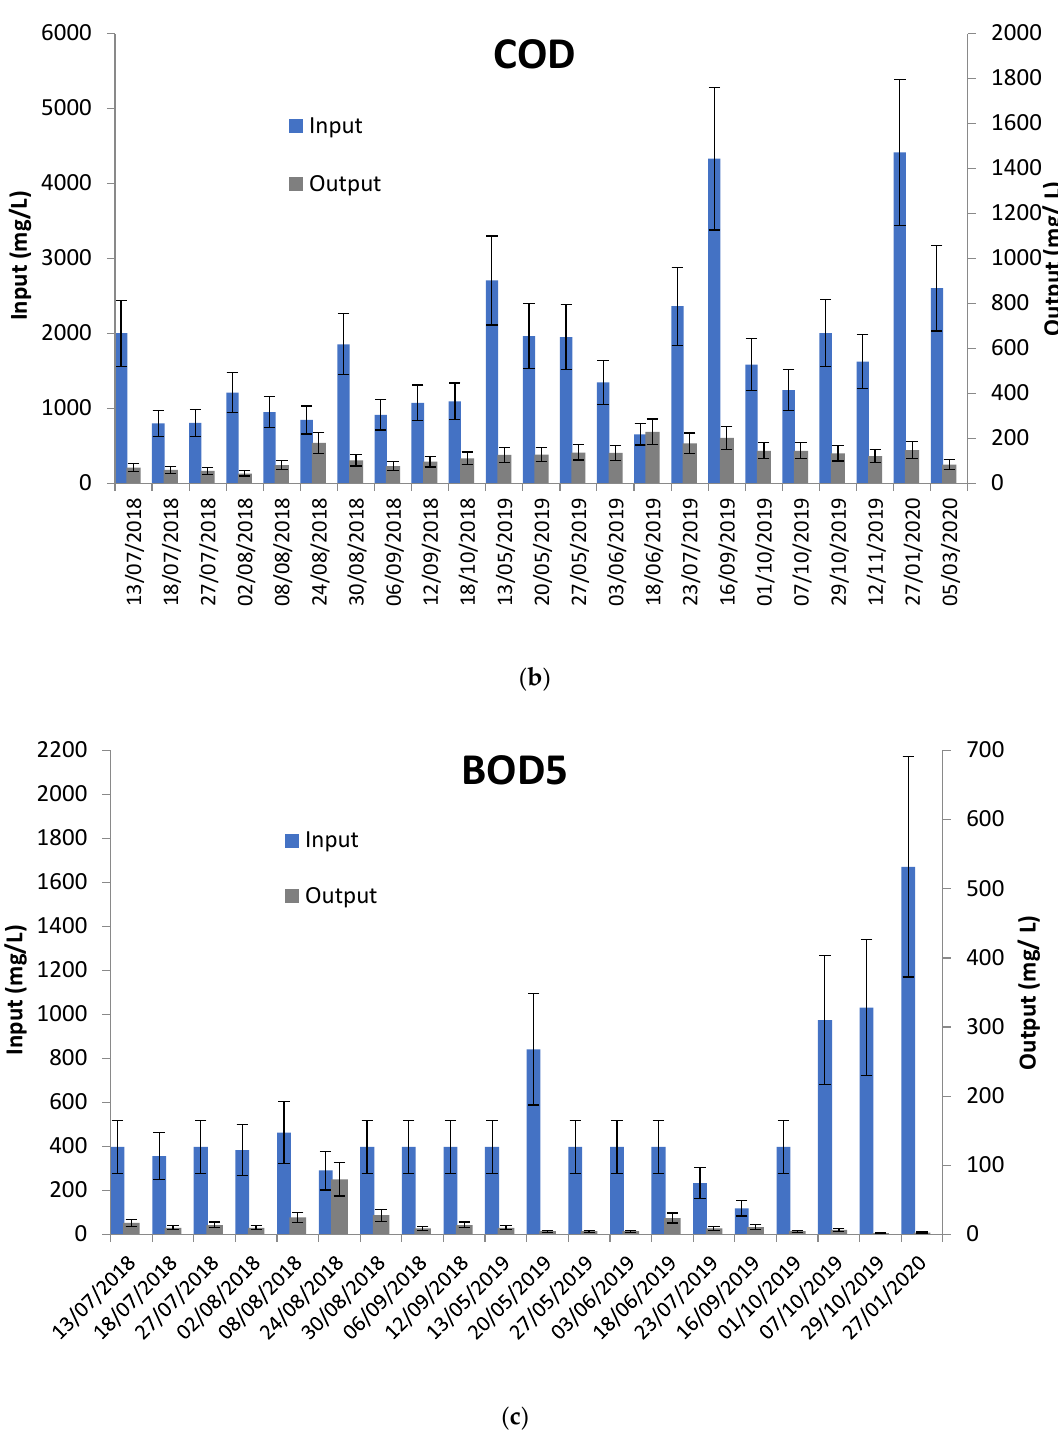
Figure 3. Organic matter concentrations and total suspended solids (TSS) at the input and the output of the plant. Blue bars show input concentration to the plant and grey bars output concentration of the hydrolytic up-flow sludge bed (HUSB). ( a ) TSS; ( b ) chemical oxygen demand (COD); ( c ) 5-day biological oxygen demand (BOD5).